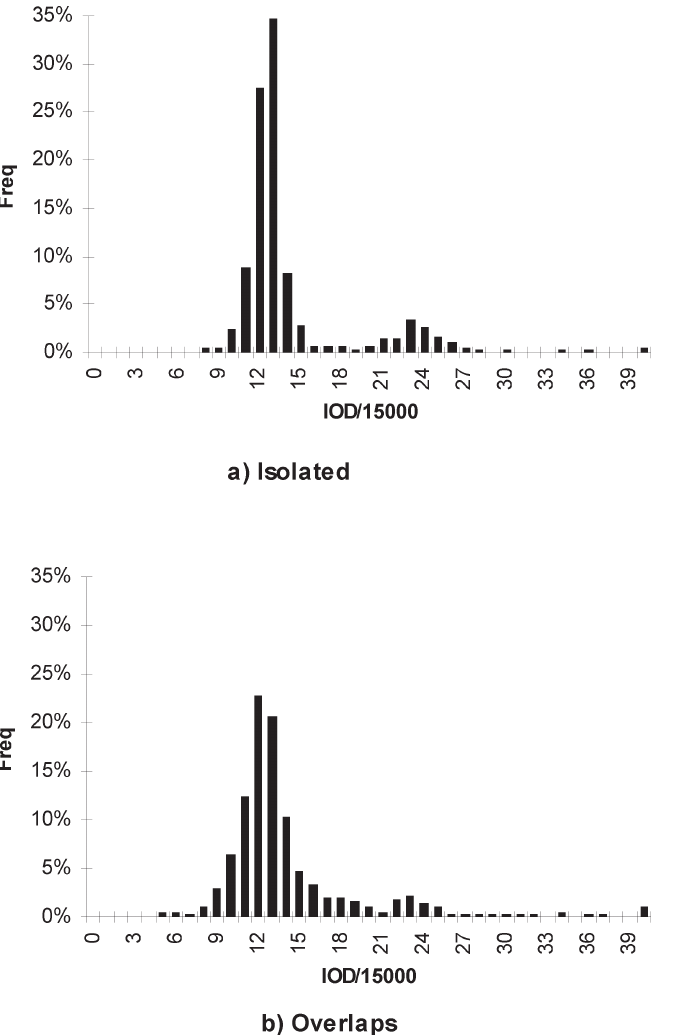
Fig. 5. (a) Histograms of isolated cells from automatic 3D segmentation. (b) Histograms of overlapping cells from automatic 3D